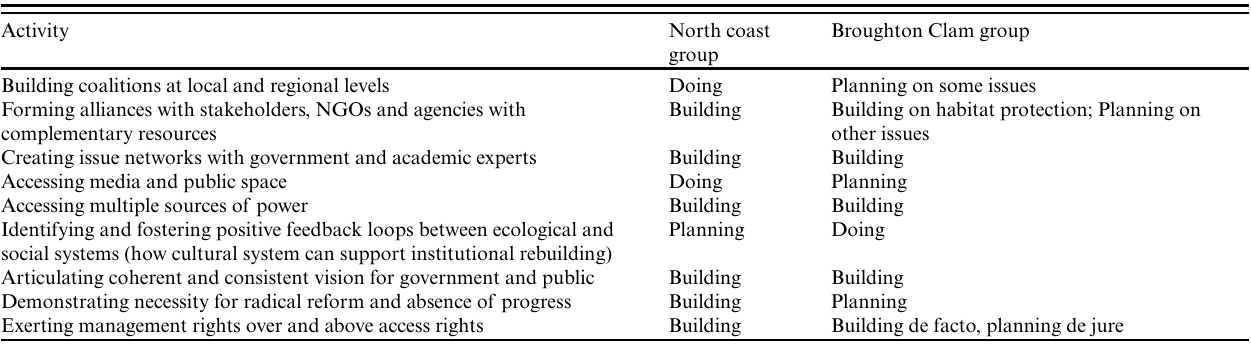
Table 9 . Activities that support rebuilding local fisheries management institutions: assessment and comparison of Skeena and Broughton